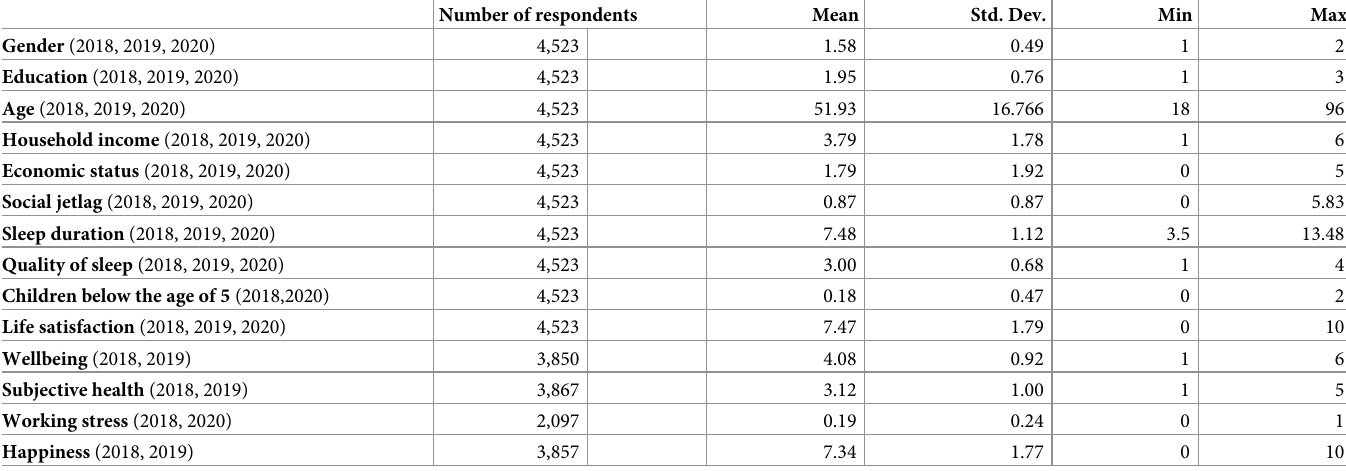
Table 1. Descriptive statistics of used